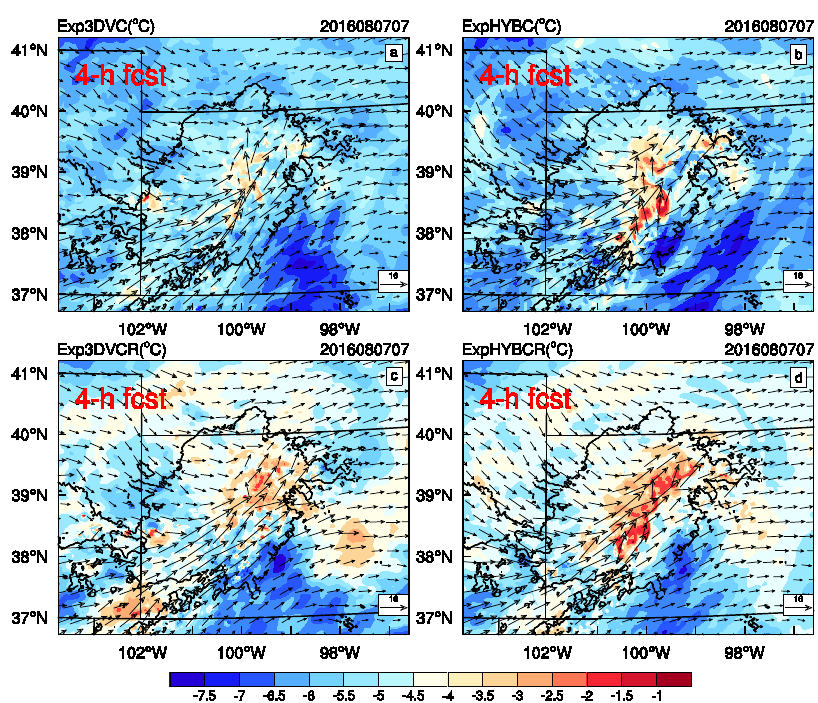
Figure 17. Temperature (unit: °C) and wind (unit: m s − 1 ) of: Exp3DVC ( a ); ExpHYBC ( b ); Exp3DVCR ( c ); and ExpHYBCR ( d ) of the convective system at 500 hPa at 07:00 UTC on 7 August 2016 (initialized at 03:00 UTC on 7 August 2016). Solid black lines represent contours of observed reflectivity exceeding 20 dB Z .